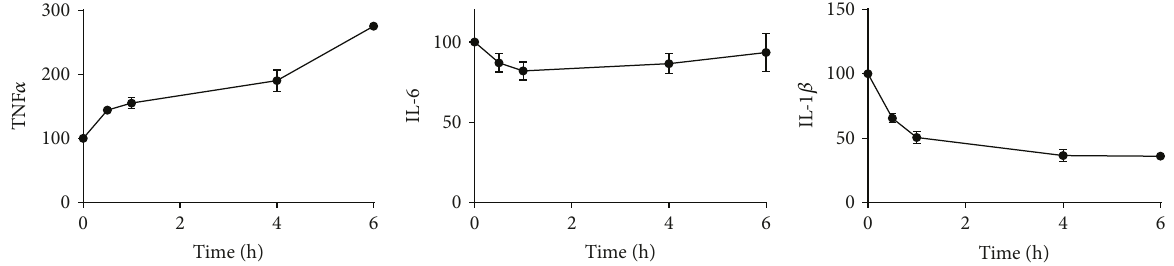
Figure 5: Cytokine release in PBMC culture supernatants (as % of the response at t = 0 , average plus SD). Isolated PBMCs of 2 donors were stimulated for 24 hours with 2 ng/mL LPS directly after isolation or after aging up to 6 hours in RPMI +10% FBS. The x -axis indicates the sample age (time span between PBMC isolation and start incubation). Cells were stored at room temperature. For IFN γ , most samples remained below